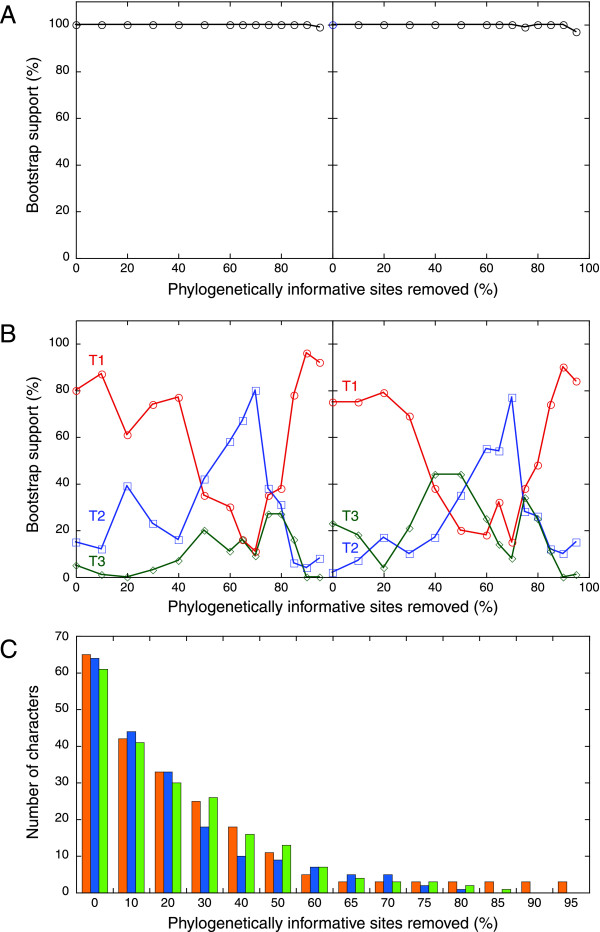
Influence of removing increasing proportions of fast-evolving sites in the amino acid data set on the robustness of the nodes supporting the Chlorokybus + Mesostigma clade and the three possible positions identified for this clade. A series of data sets lacking 10% to 90% of the 4,179 phylogenetically informative sites present in the original data set analyzed in Figure 2A were subjected to phylogenetic analyses. (A) Fluctuations of bootstrap values for the node supporting the Chlorokybus + Mesostigma clade in ML (left side) and MP (right side) analyses. (B) Fluctuations of bootstrap values for the nodes supporting the T1, T2 and T3 placement of the Chlorokybus + Mesostigma clade in ML (left side) and MP (right side) analyses. The three topologies tested are colour-coded as follows: red, T1 topology, i.e. the placement of the clade before the divergence of the Streptophyta and Chlorophyta; blue, T2 topology, i.e. the placement of the clade as sister to the Streptophyta; and green, T3 topology, i.e. the placement of the clade as sister to the Chlorophyta. (C) Fluctuations in the number of characters supporting unambiguously each of the three topologies identified for the Chlorokybus + Mesostigma clade. The topologies are colour-coded as in (B).